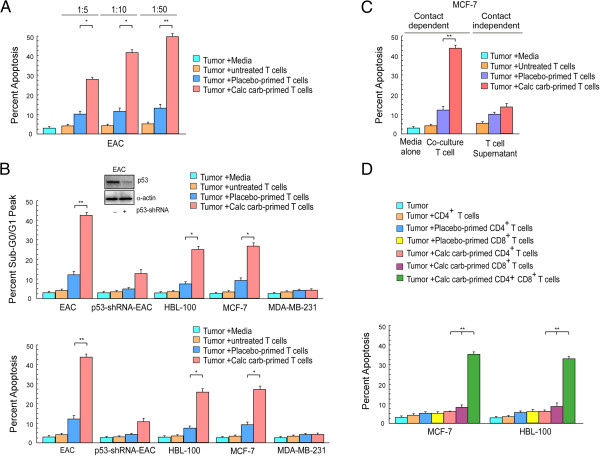
Calcarea carbonica potentiates T cell-mediated cancer cell killing in vitro. (A) Percent apoptosis of EAC cells co-cultured with T cells at multiple effector to target ratios (5:1, 10:1 and 50:1), isolated from untreated or placebo-/calcarea carbonica-treated tumor-bearing mice. Further for all co-culture experiments effector to target ratio was kept as 10:1. (B) Graphical representation of sub-G0/G1 populations and Annexin-V-positive populations amongst EAC and p53-silenced EACs co-cultured with or murine T cells from untreated or placebo-/calcarea carbonica-treated tumor-bearing mice. Similarly human breast cancer cell lines, MCF-7/HBL-100/MDA-MB-231 cells were co-cultured with human T cells for 48 h to determine tumor cell apoptosis. Prior to co-culture, these human T cells were primed with placebo-/calcarea carbonica-treated tumor supernatant for 72 h. The transfection efficacy of p53-shRNA was determined by Western blot (inset). (C) MCF-7 cell apoptosis when co-incubated with placebo-/calcarea carbonica-primed human T cells (contact-dependent) or with supernatants of placebo-/calcarea carbonica primed T cells (contact-independent) was determined flow cytometrically. (D) Percent apoptosis of MCF-7/HBL-100 cells when co-cultured with placebo-/calcarea carbonica-primed CD4+ and/or CD8+ T cells. Values are mean ±SEM of five independent experiments. *p < 0.05 and **p < 0.001 when compared with respective tumor-bearing control/drug-treated sets and placebo-treated/drug-treated sets.